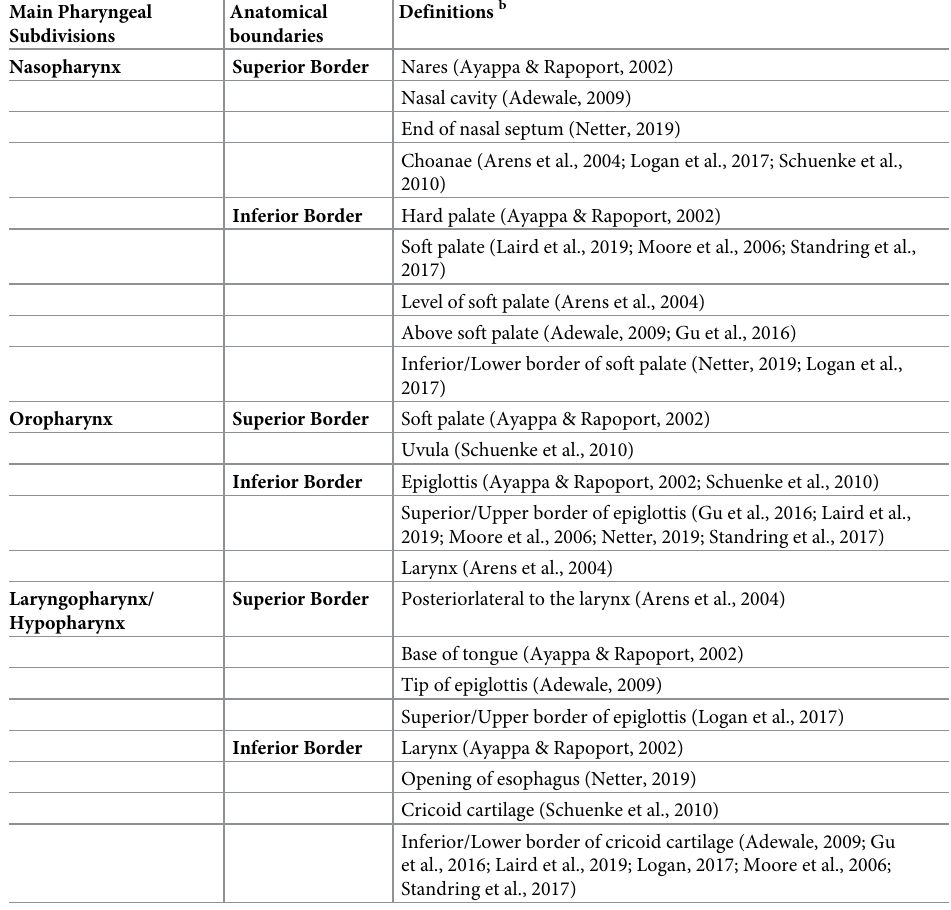
Table 2. Summary of boundaries of the pharyngeal